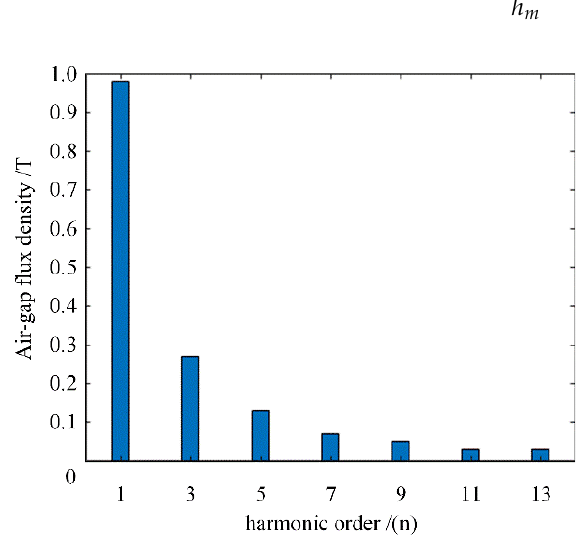
Figure 4. No-load air-gap magnetic density harmonic.